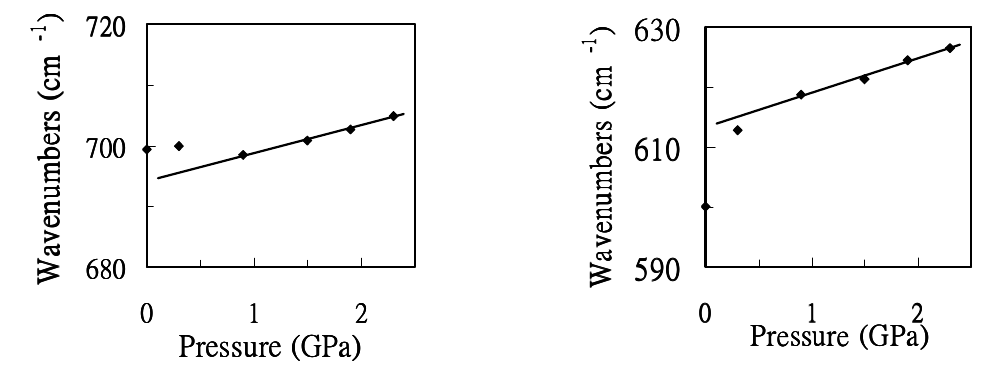
Figure 5. Pressure dependence of the maximum positions of the characteristic bands at ca. 700 and 600 cm -1